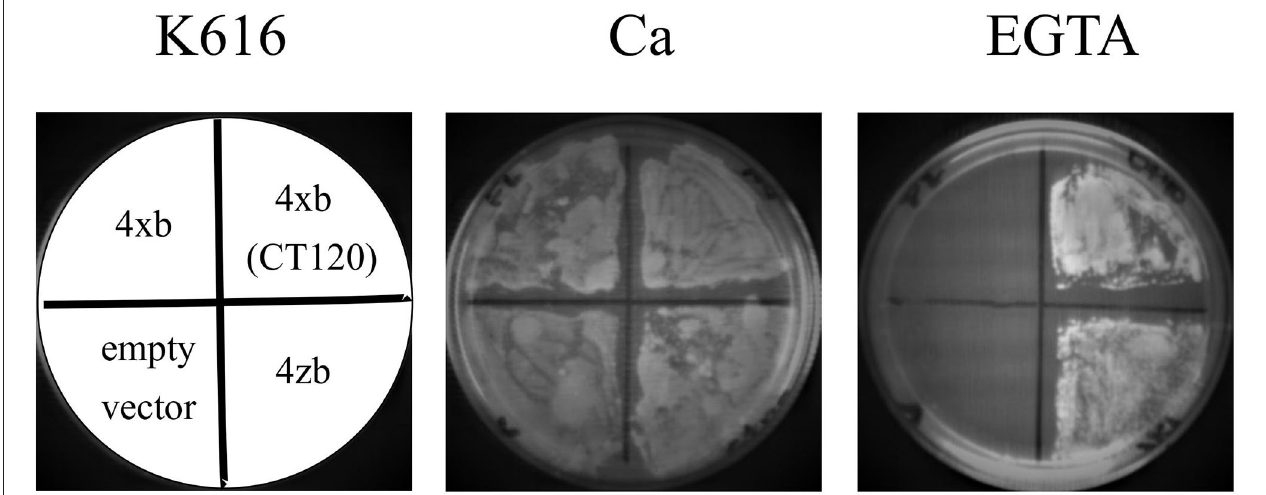
FIGURE 2 | PMCA4xb-GFP complements the K616 yeast strain lacking endogenous Ca 2 + ATPases. K616 cells were transformed with the empty pYX112 vector, or vector containing PMCA4xb-GFP, PMCA4zb-GFP, or the hyperactive mutant PMCA4x(CT120)-GFP lacking the C-terminal 120 amino acids segment containing the autoinhibitory domain. Cultures of K616 yeast expressing the recombinant PMCA proteins were grown for 72h at 28 ◦ C on SC-Ura − plates containing 10mM CaCl 2 or 10mM